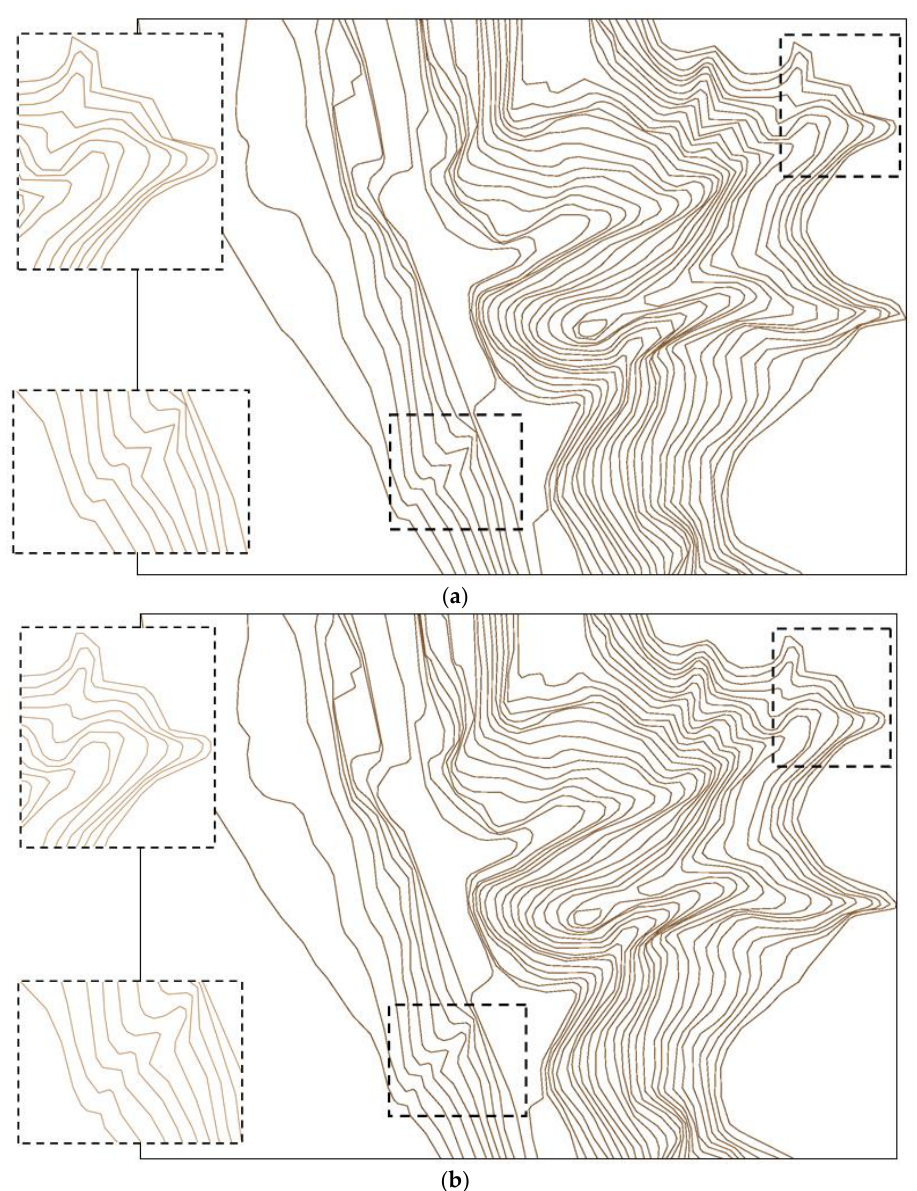
Figure 20. Comparison of the simplified results with similar compression rates: ( a ) simplified results with the orthographic division and DP-algorithm (composed of 1580 shape points); and ( b ) Simplified result with the ODC method and DP-algorithm (composed of 1518 shape points).